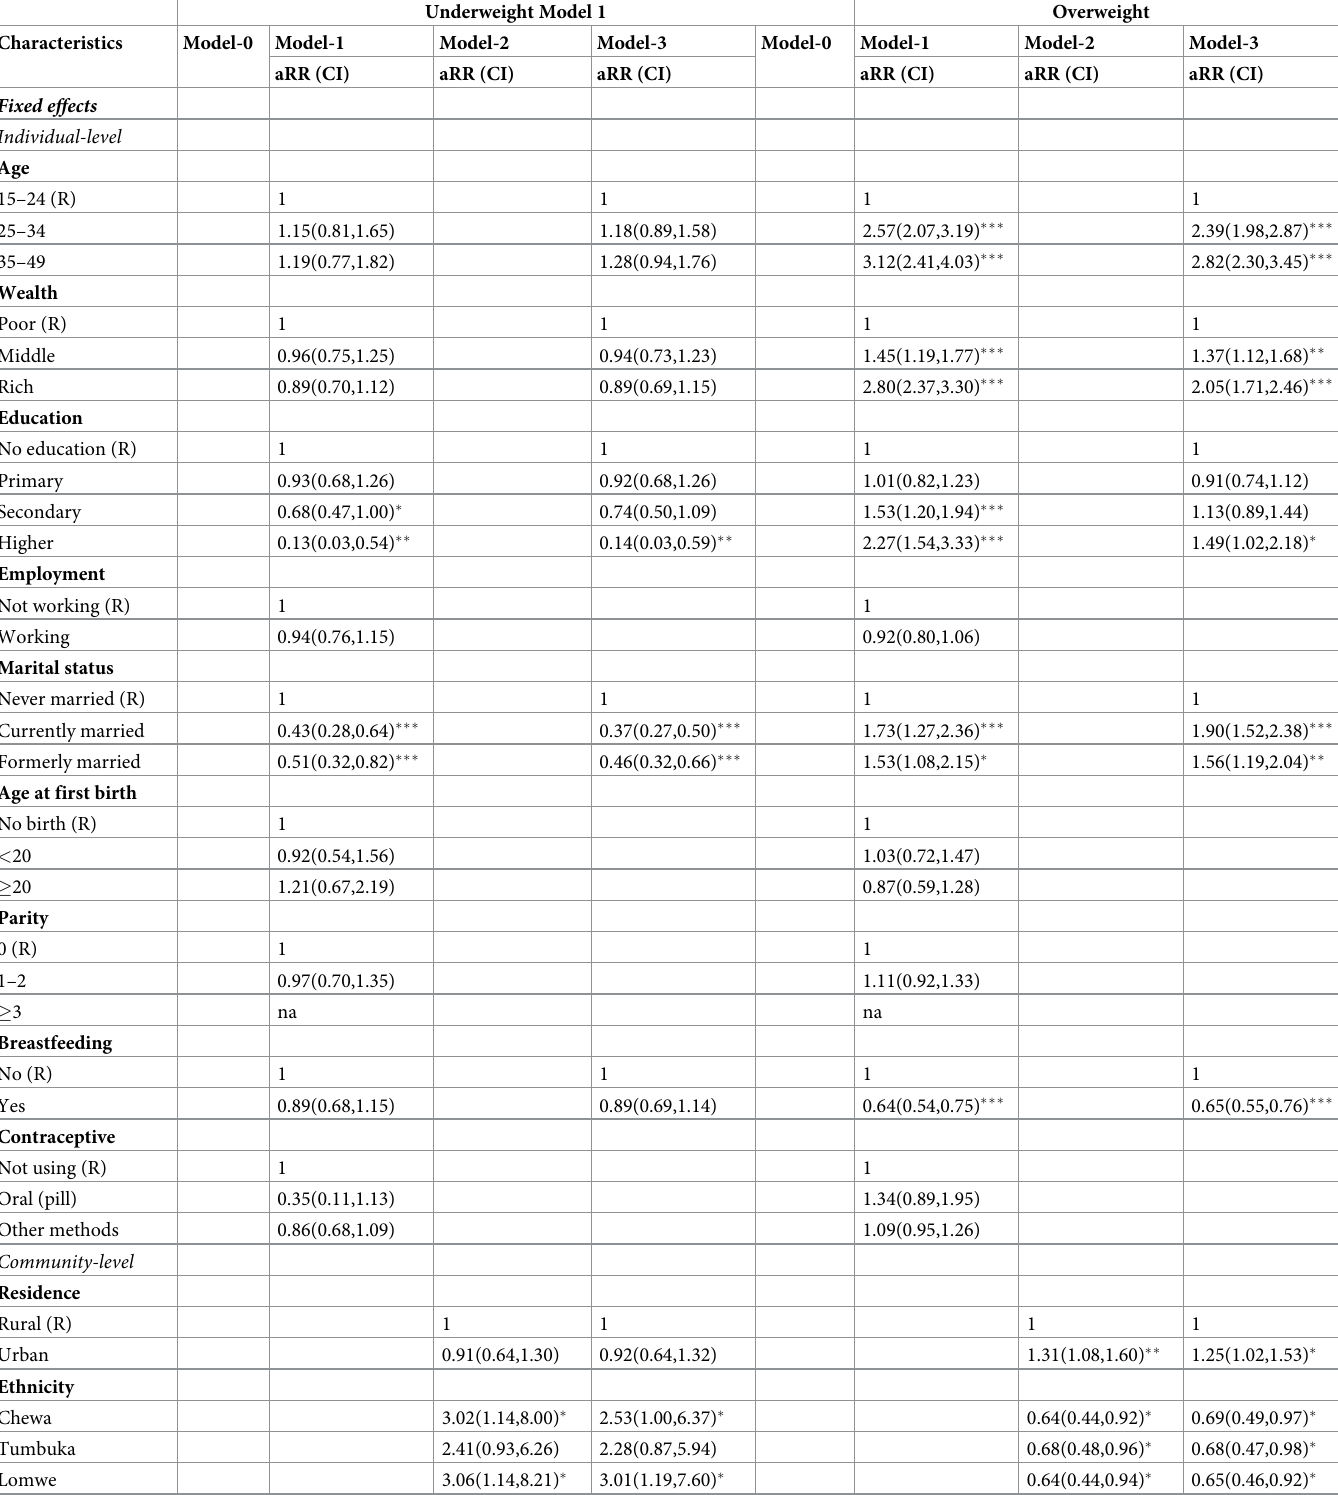
Table 2. Effects of individual- and community characteristics on women’s unhealthy bodyweight in